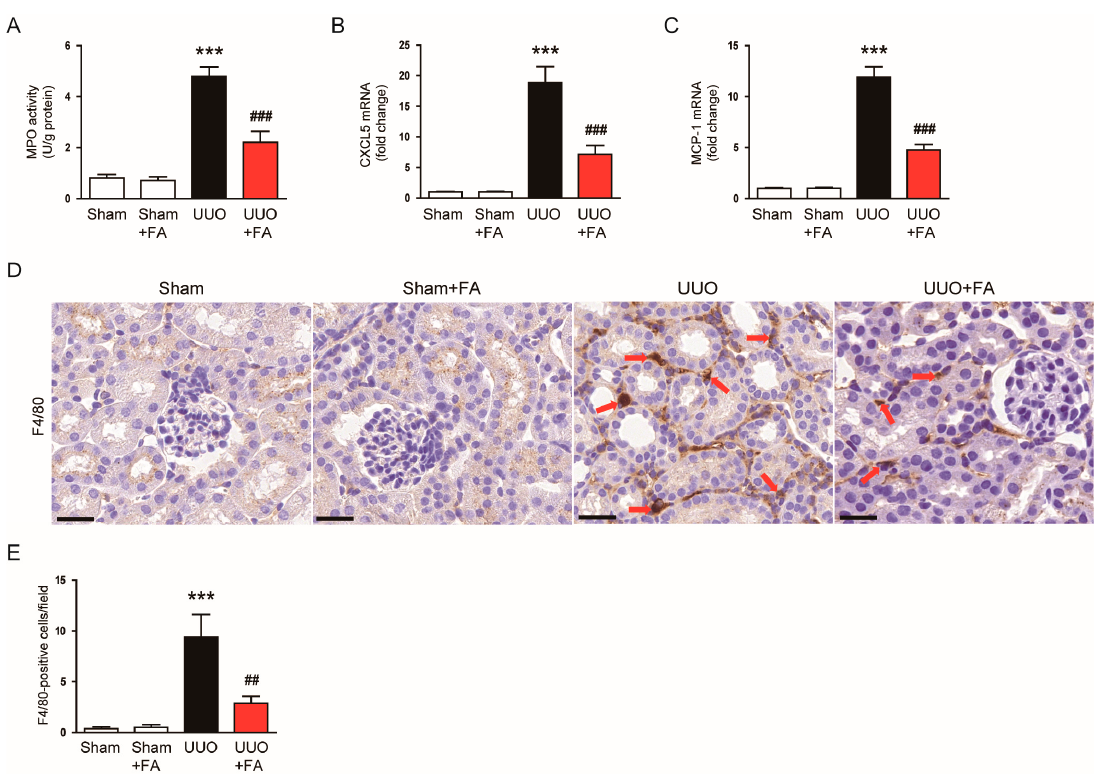
Figure 10. Effects of FA on macrophage infiltration in UUO mice. ( A ) Renal MPO activities. ( B ) Renal CXCL5 and MCP-1 mRNA levels. ( C ) IHC staining for F4/80. Scale bar = 60 μ m. Red arrows CXCL5 and MCP-1 mRNA levels. ( D ) IHC staining for F4/80. Scale bar = 60 µ m. Red arrows indicate indicate positively stained cells. ( D ) Number of F4/80-positive cells per field. *** p < 0.001 vs. Sham. positively stained cells. ( E ) Number of F4/80-positive cells per field. *** p < 0.001 vs. Sham. ## p < 0.01 ## p < 0.01 and ### p < 0.001 vs. UUO. and ### p < 0.001 vs.